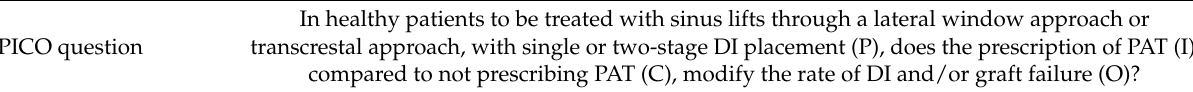
Clinical Problem